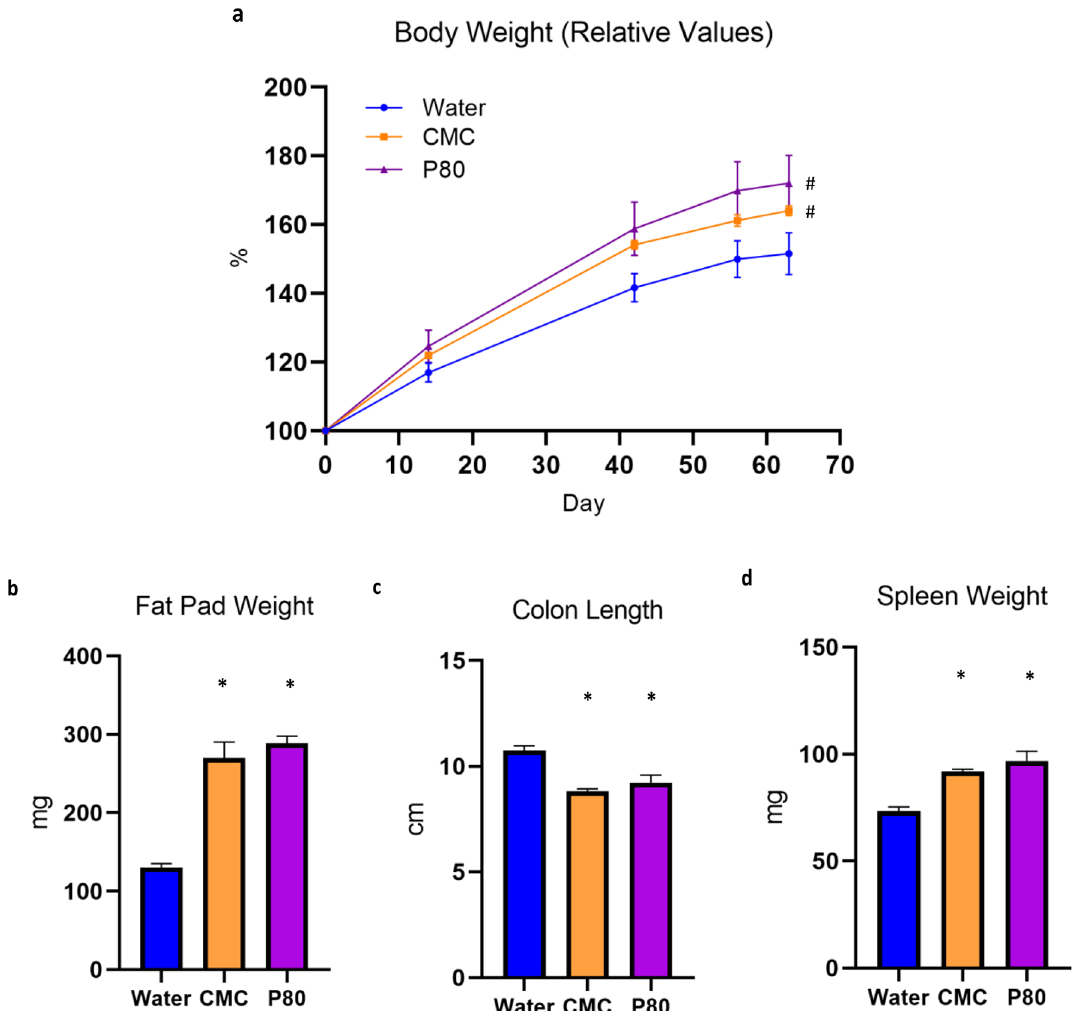
Figure 1. Emulsifier consumption results in metabolic syndrome and low-grade inflammation. ( a ) Relative body weight over time. Body weight is expressed as a percentage compared to the initial body weight (Day 0) defined as 100%. Ingestion of emulsifiers significantly increased fat-pad mass ( b ), decreased colon length ( c ), and increased spleen weight ( d ) compared to controls. Significance was determined using a repeated measure one-way ANOVA with a Geisser-Greenhouse correction ( # p < 0.05) or unpaired t-tests (*p < 0.05). N = 5 in each